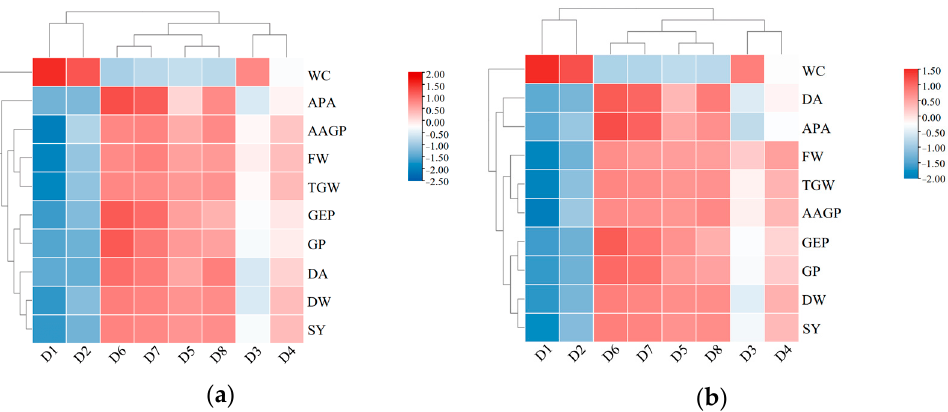
Figure 4. Heatmaps showing a log 2 -fold change in seed yield and quality observed in K. melanthera based on different days after peak anthesis during the trial years 2016 ( a ) and 2017 ( b ). Up-regulated and down-regulated indices are indicated by red and blue, respectively. Note: WC, water content; FW, fresh weight; DW, dry weight; SY, seed yield; TGW, thousand-grain weight; GEP, germination percentage; GP, germination potential; AAGP, accelerated aging germination percentage; DA, de-